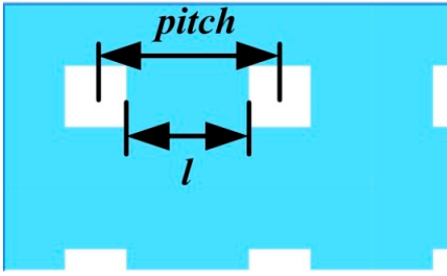
Figure 7. Scheme of the mesh size distribution.